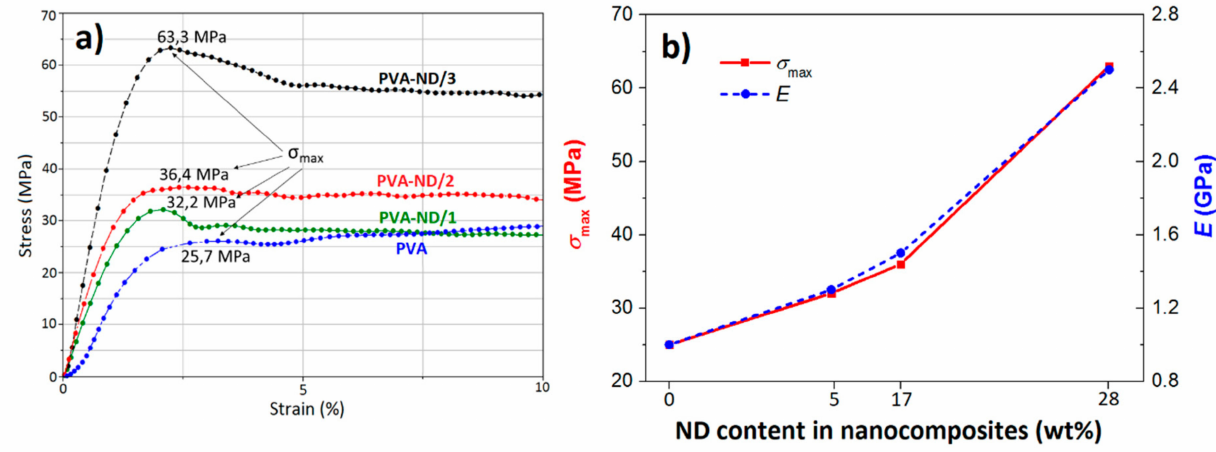
Figure 10. ( a ) σ - ε graph of the PVA and the PVA-ND nanocomposites and ( b ) dependence of the tensile strength ( σ max ) and Young’s modulus ( E ) on the ND content of the PVA-ND